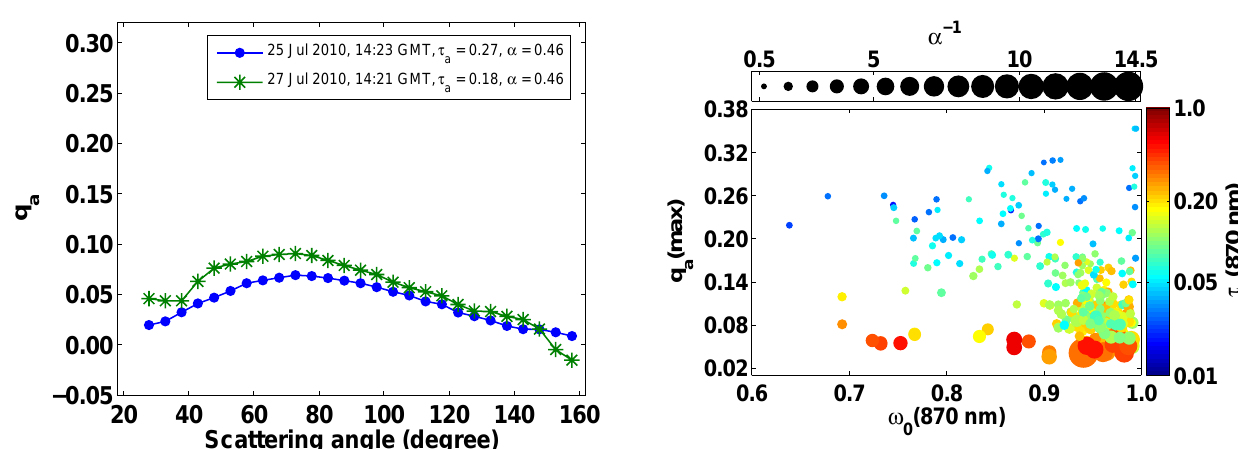
Fig. 6. Retrieved q a at 870nm versus the scattering angle in the atmosphere of Zanjan for two measurements with same α and dif- ferent τ a , IASBS site.